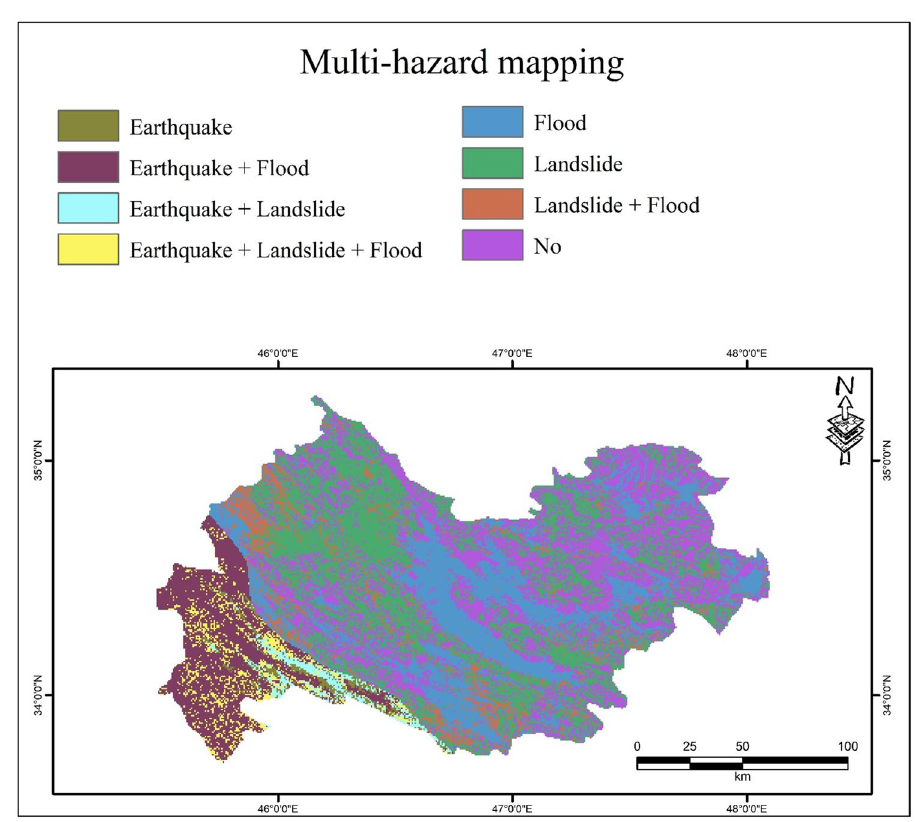
Figure 5. Multi-hazard map for the Kermanshah province using ArcGIS 10.3.1